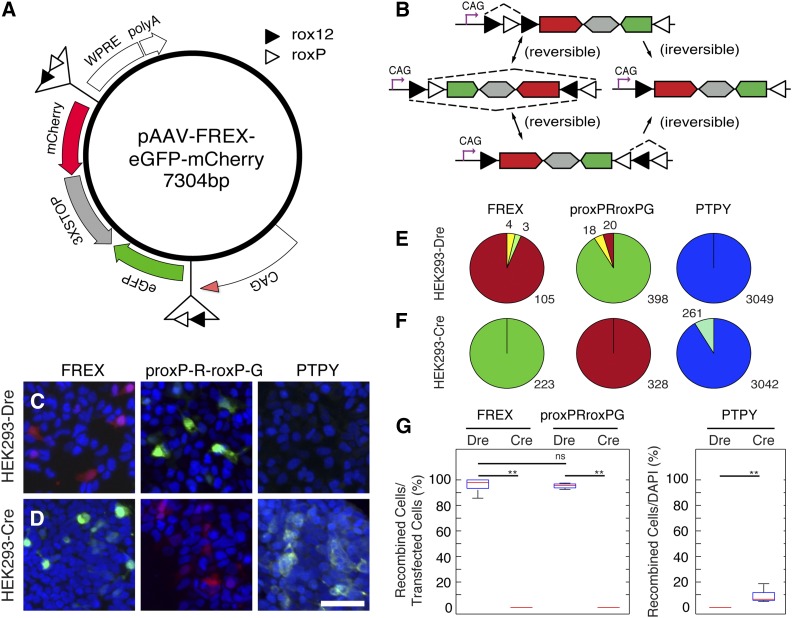
Efficient Dre recombination using an inversion–excision cassette (FREX) based on rox12 and roxP. (A) The pAAV-FREX-eGFP-mCherry eukaryotic viral expression vector contains a CAG promoter driving an expression cassette flanked by tandem rox12-roxP sites. The cassette contains eGFP and mCherry cDNAs placed in reverse orientation to each other, and separated by a triple repeat of a bidirectional SV40 transcription stop/polyadenylation signal. WPRE and bGH elements ensure mRNA stability and processing and AAV2 ITRs (not shown) allow for viral packaging. (B) Dre induces two alternative inversion reactions (double arrows) followed by irreversible excision (single arrow) reactions. The CAG promoter drives transcription of eGFP before, and of mCherry after, Dre recombination. HEK293-Dre (C) or HEK293-Cre (D) cells were transfected with FREX (column 1), prox-R-rox-G (column 2), or pAAVPTPY, a FLEX-based Cre reporter plasmid (column 3). (E, F) Numbers in pie charts for columns 1 and 2 indicate the sums for red (mCherry only), green (eGFP only), and yellow (double positive) cells. Results from cells transfected with pAAVPTPY (cyan) are shown in column 3 (E, F), comparing recombined cells to the total number of cells (DAPI, blue). Only Hek293Cre cells recombined the PTPY construct. (G) Box-whisker plots quantitating the percent of recombination positive cells. The percentage represents 100 × (mCherry+ + eGFP+mCherry+)/(eGFP+ + eGFP+mCherry+ + mCherry+) for FREX transfections or 100 × (eGFP+ + eGFP+mCherry+)/(eGFP+ + eGFP+mCherry+ + mCherry+) for pRoxP-R-roxP-G transfections. Recombination of PTPY is represented by 100 × Cyan+/DAPI+. Recombination efficiency was not statistically significant between the FREX and pRoxP-R-roxP-G in Dre-expressing cells. Statistical significance was determined with student t-test and Kolmogorov–Smirnov test (n.s. = P > 0.05, ** = P < 0.005). Scale bar in C = 50 μm.